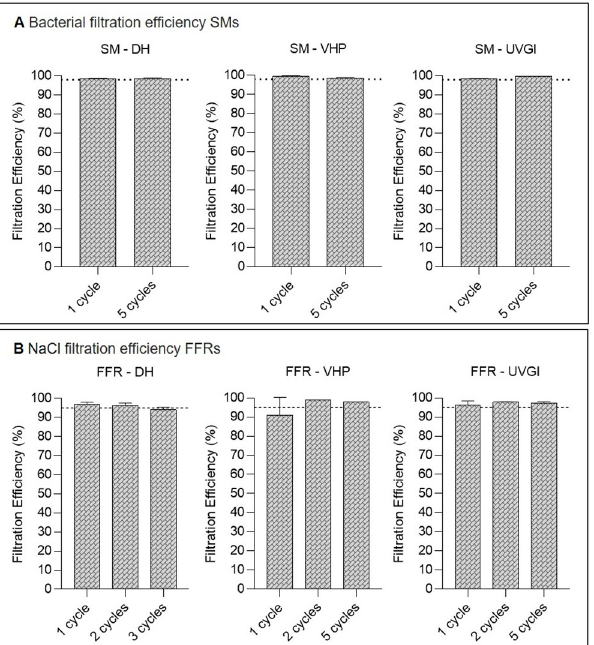
Fig 4. Filtering facepiece respirator (FFR) NaCl filtration efficiency- and surgical mask (SM) bacterial filtration efficiency (BFE) testing after single-cycle or multiple-cycle decontamination using dry heat (DH), vaporised hydrogen peroxide (VHP), and ultraviolet germicidal irradiation (UVGI). Horizontal dashed lines represent the NaCl filtration efficiency requirement of � 95% according to NIOSH 42 CFR Part 84. Untreated FFRs (n = 3) surpassed the minimum NaCl filtration efficiency, achieving 97.01% ( ± 0.56) as a baseline before treatment. Horizontal dotted lines represent the bacterial filtration efficiency (3 μ m droplet size) requirement of � 98% according to EN 14683 for Type II and ASTM F2100 for Level 2 SMs. Untreated SMs (n = 3) surpassed the minimum BFE, achieving 99.50% ( ± 0.08) as a baseline before treatment.